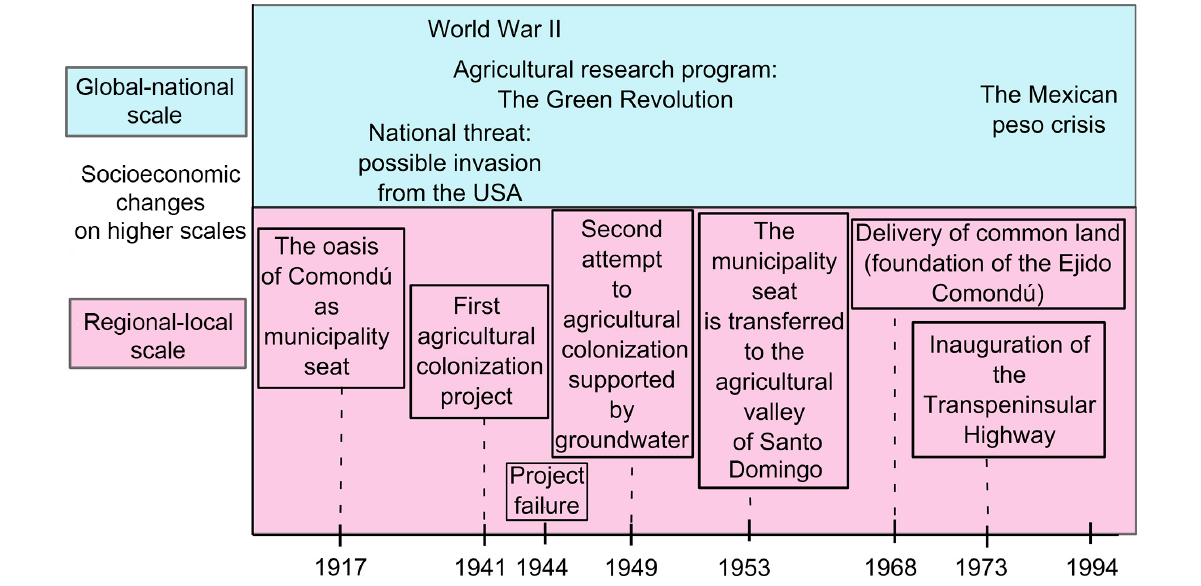
Fig. 12 . Socioeconomic changes on higher scales. The changes on the global–national scale are located on the blue stripe; regional and local changes are on the violet